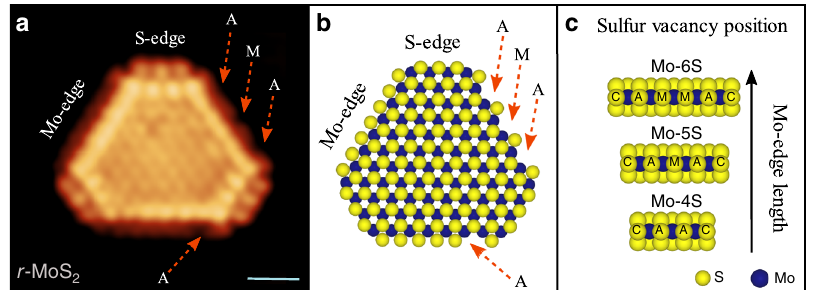
Fig. 1 Atomic-scale structure of MoS 2 nanoparticle with sulfur vacancies formed on the edges. a Atom-resolved STM image recorded at room temperature of a single-layer MoS 2 nanoparticle exposed to hydro-reductive conditions ( r -MoS 2 ) at 673 K and 10 − 4 mbar of H 2 . The red arrows indicate the position of individual sulfur vacancies (V S ) which in this case include 3 V S on A position and 1 V S on an M position. STM parameters: V t = − 0.32 V, I t = − 0.42 nA. Scale bar is 1 nm. The STM image in a of r- MoS 50 (reprinted with permission). b Left part: Top-view ball model of the r - 2 is adapted from ref. MoS 2 particle in (a) (S: yellow, Mo: blue). The truncated MoS 2 crystal is bounded by three short S-edges and three longer Mo-edges with a nominal 50% S-coverage consisting of S-monomers at a bridge position between Mo atoms, as in ref. 50 . Sulfur vacancies are indicated by a red arrow. c Side-view ball model of the Mo-edge with a nominal coverage of 50% for three different edge lengths (4, 5, and 6 monomers, respectively). The overlaid notations for edge site locations are (C) corner, (A) adjacent to corner and (M) middle positions, respectively.